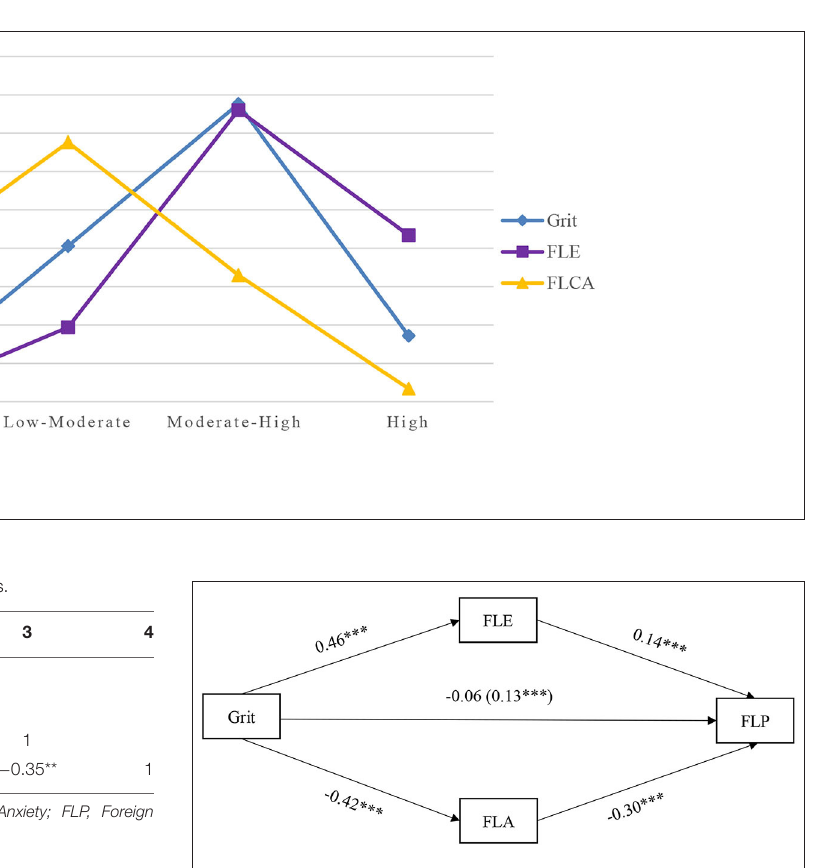
FIGURE 2 | The model of multiple mediation analysis. Values on paths are path coefficients (standardized β s). Path coefficient in parentheses is total effect. FLE, Foreign Language Enjoyment; FLA, Foreign Language Anxiety; FLP, Foreign Language